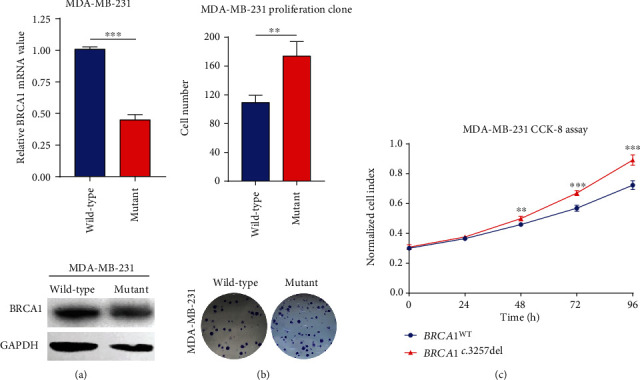
(a) The BRCA1 mRNA level of MDA-MB-231 transfected with BRCA1c.3257del plasmids was significantly reduced (P < 0.05) compared to those transfected with wild-type BRCA1 plasmids. Western blot analysis showed that the BRCA1 protein level translated by BRCA1c.3257del-overexpressed cells was lower than BRCA1WT in MDA-MB-231 cells. (b) The colony formation efficiency of MDA-MB-231 cells transfected with BRCA1c.3257del was significantly increased (P < 0.05). (c) Cell proliferation of BRCA1c.3257del (red) and BRCA1WT (blue) was measured using the CCK-8 assay. Increased proliferation of BRCA1c.3257del-overexpressing MDA-MB-231 cells was detected in vitro (P < 0.05).